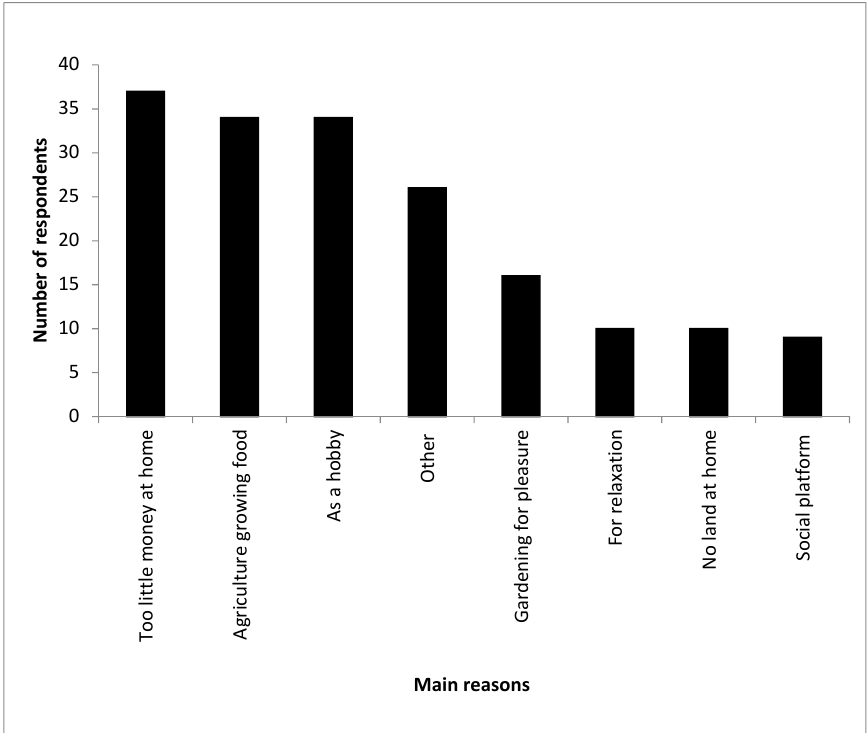
Figure 2. Primary reasons of respondents engaged in urban community agriculture.